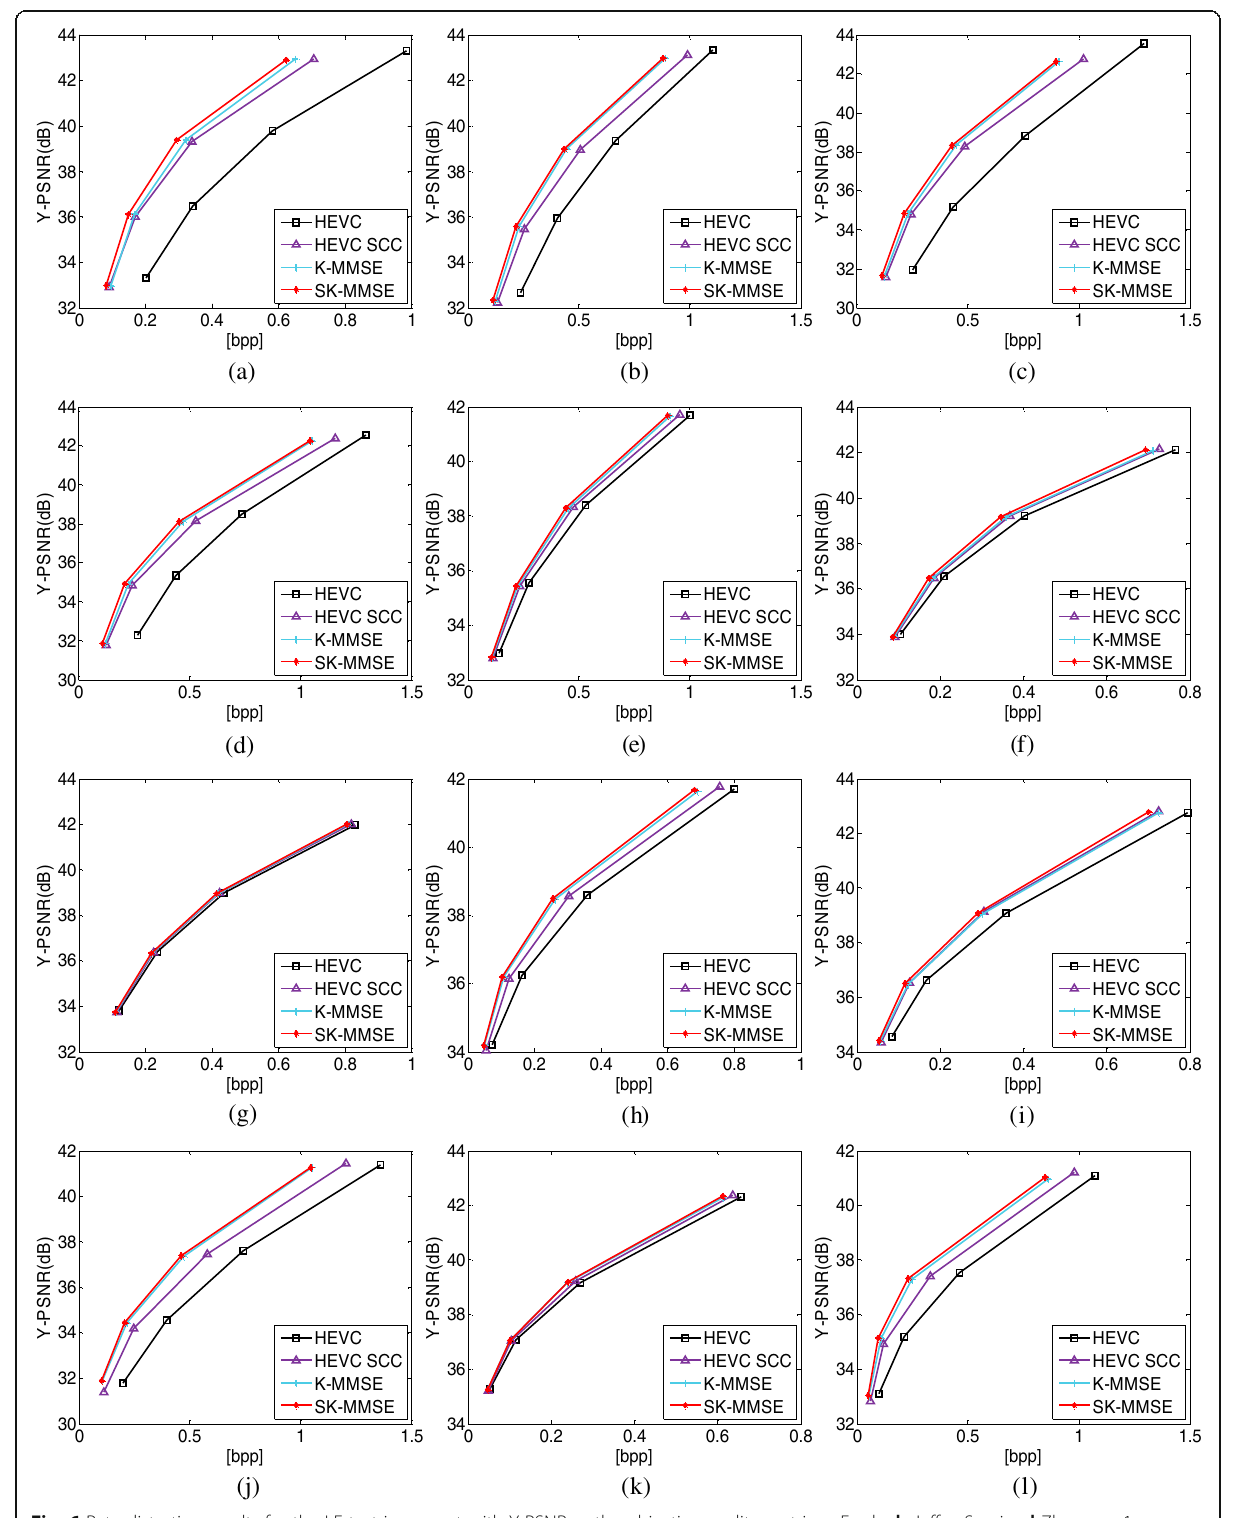
Fig. 6 Rate-distortion results for the LF test image set with Y-PSNR as the objective quality metric. a Fredo, b Jeff, c Sergio, d Zhengyun1,